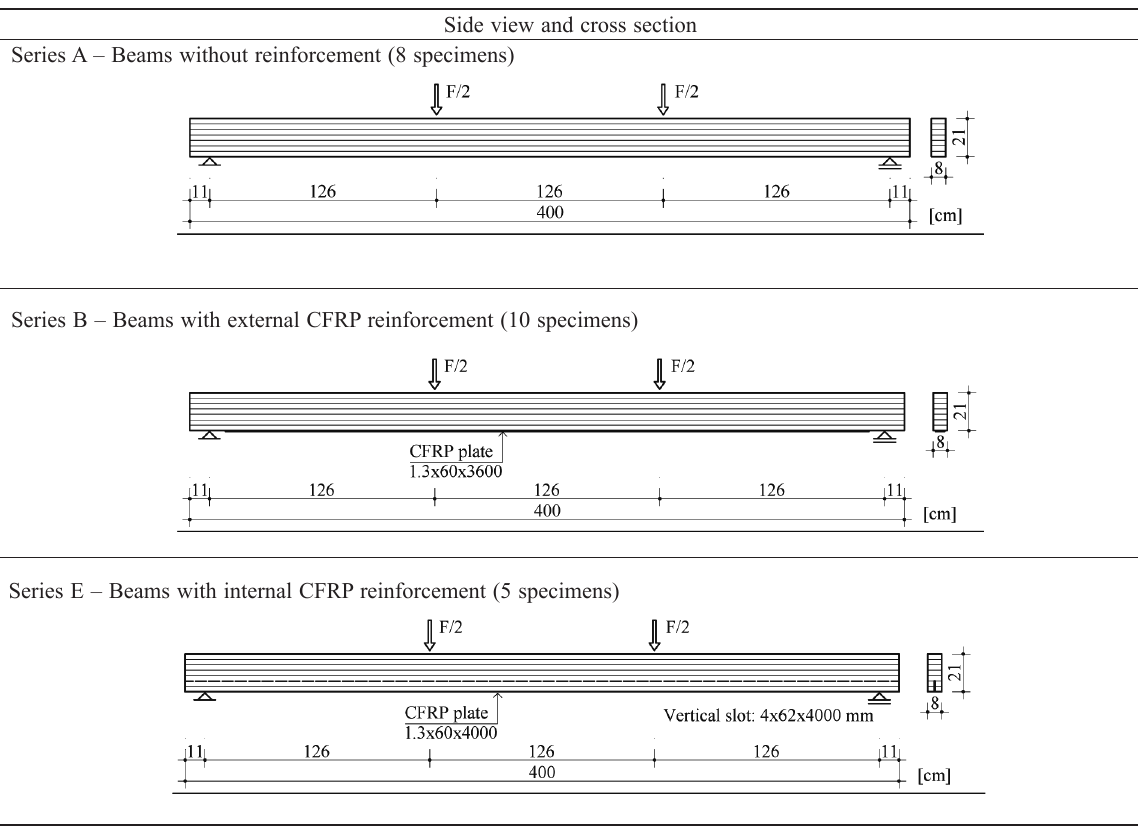
Table 3. Geometry of unreinforced and reinforced glulam beams